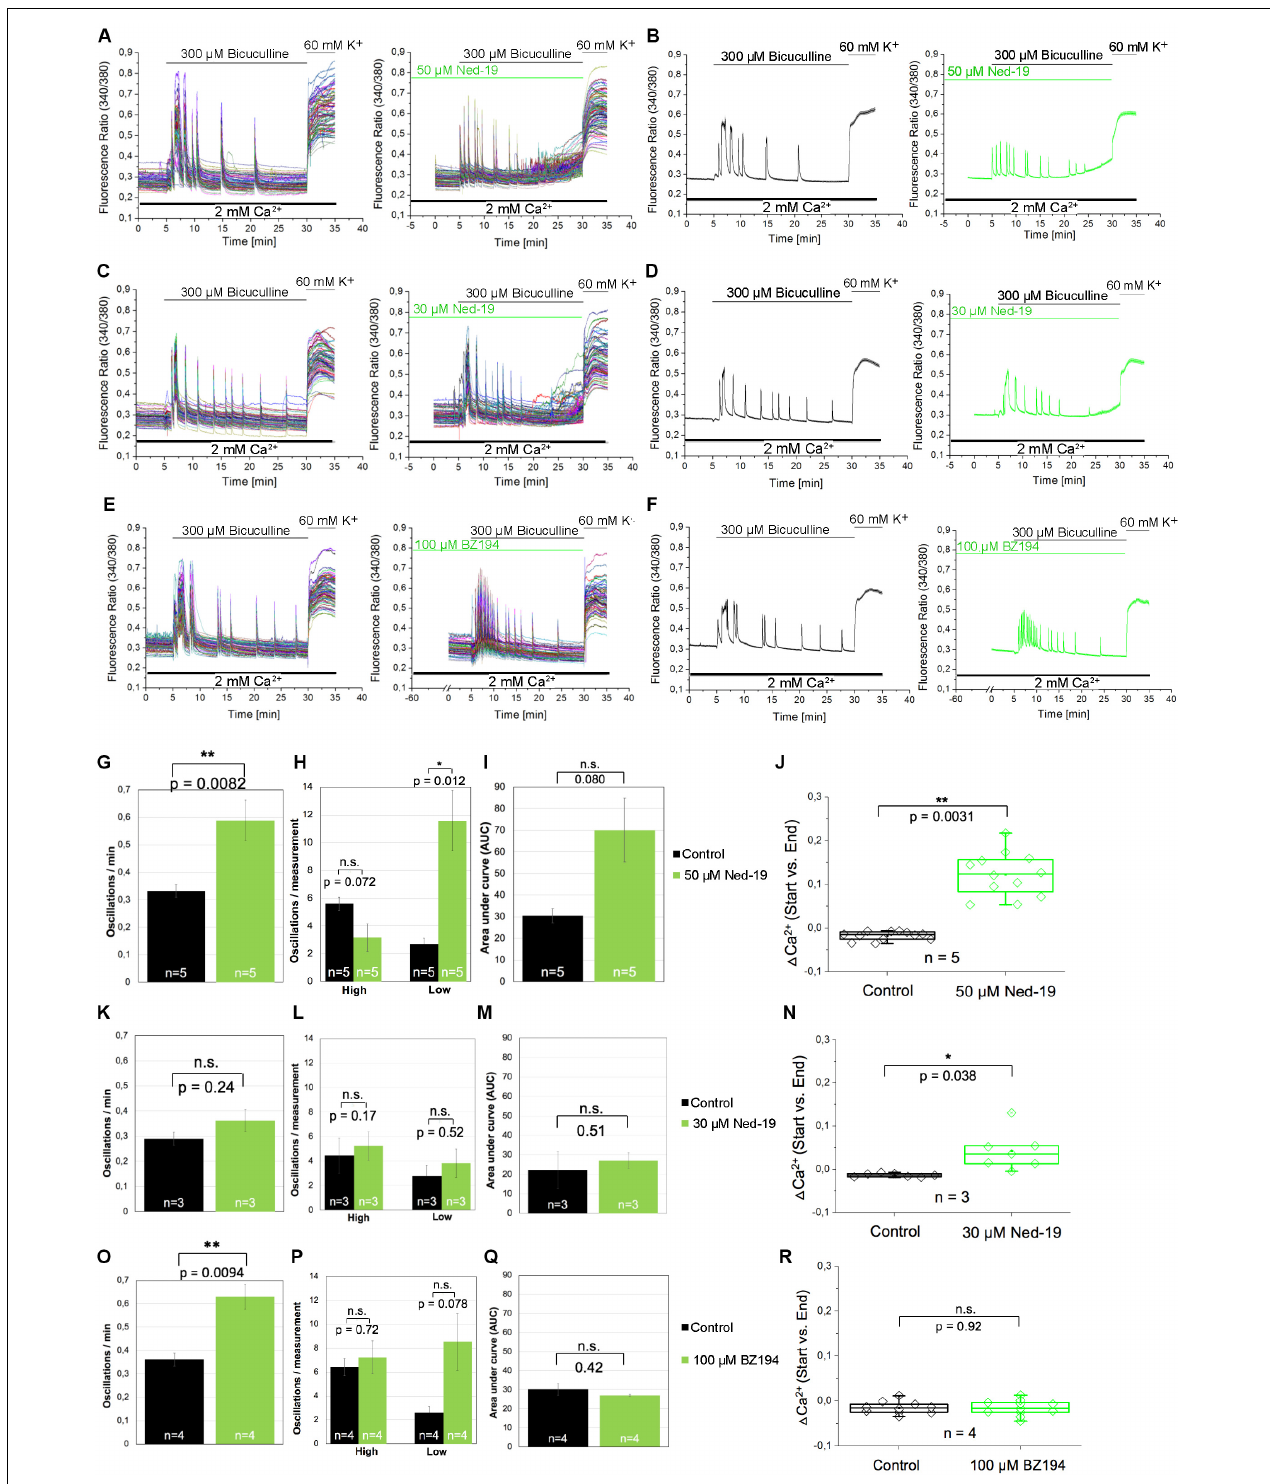
FIGURE 5 | The effect of the NAADP antagonists Ned19 and BZ194 on Ca 2 + transients triggered by glutamate release events following inhibition of GABA A receptors in hippocampal neurons. (A,C,E) Representative traces of the bicuculline-induced changes in the F340/380 fluorescence intensity values in hippocampal neurons without (left) and with (right) preincubation with Ned-19 (50 µ M; A or 30 µ M; C ) or BZ194 (100 µ M; E ). (B,D,F) Average traces are given as the arithmetic mean ± SEM without (black) and with (green) the corresponding NAADP antagonists (50 µ M Ned-19, n = 89 cells, B ; 30 µ M Ned-19, n = 86 cells, D